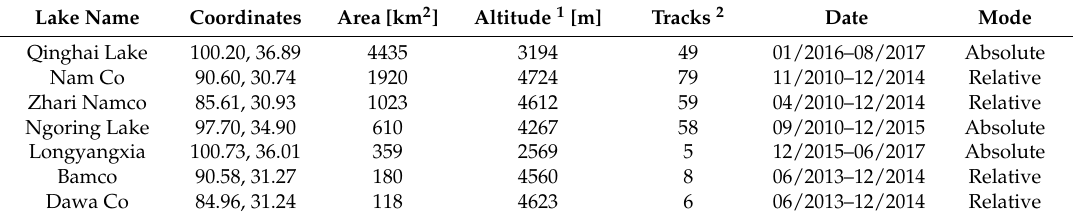
Figure 1. Lakes and corresponding Cryosat-2 SARin tracks. Blue and gray solid lines represent the observations of icing and no-ice periods, respectively. Red circles mark the locations of fixed measuring stations. Table 1. Details of the seven lakes used in the present